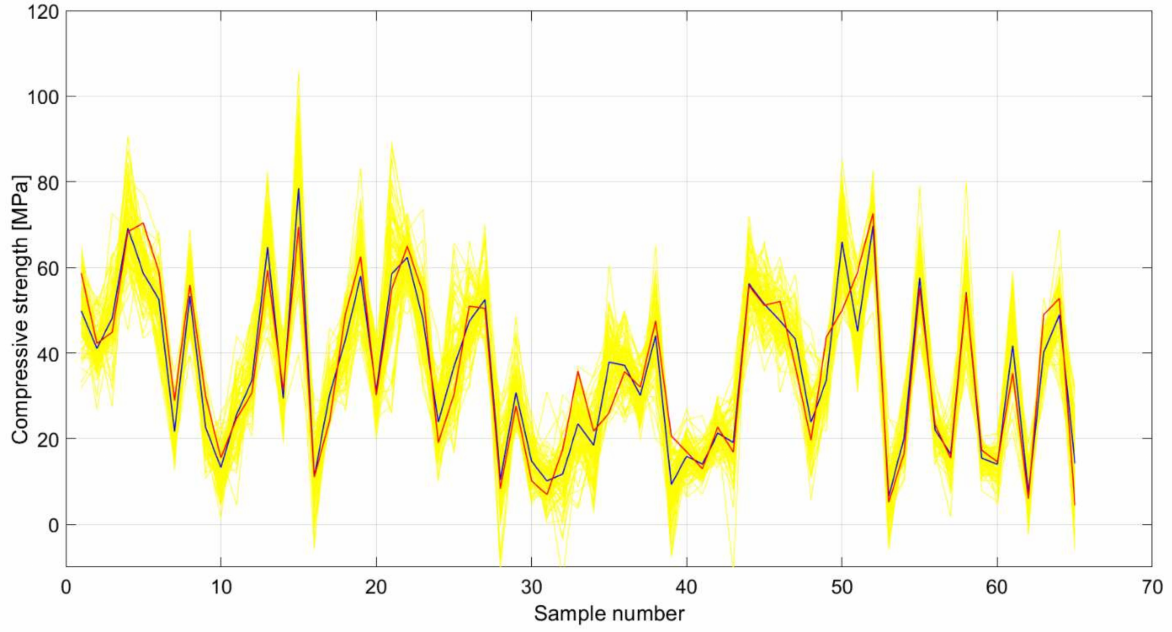
Figure 21. Comparative analysis of anensemble of ANNs (blue color) and individual ANN models (yellow color) in relation to target test values (red color) for SCC with Class F fly ash compressive